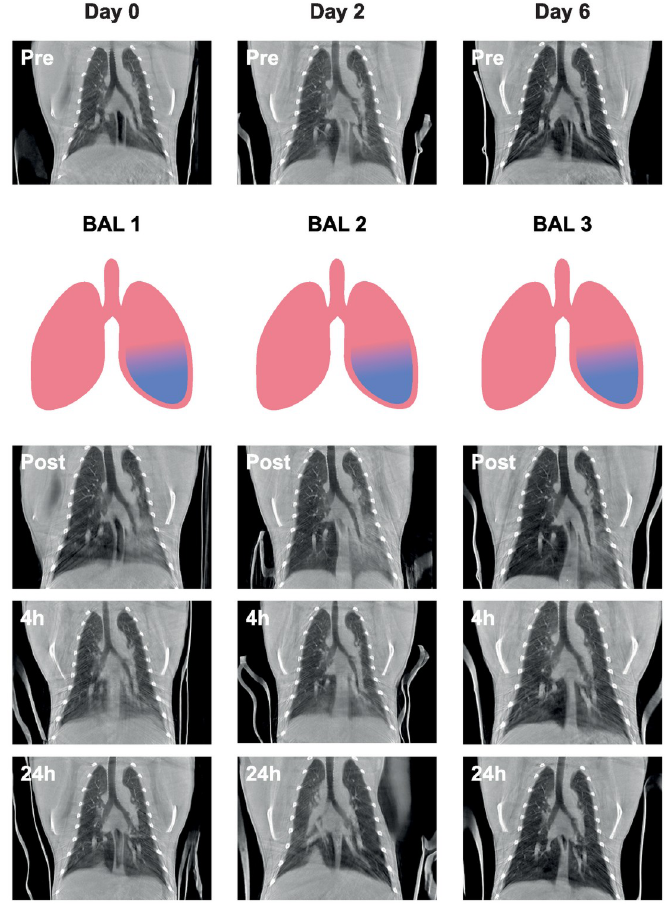
Fig 1. Representative coronal slices (of RM2) of all CTs obtained during the three BALs. The procedures are represented in a vertical manner whereas the time in days is represented horizontally. The procedure starts with a pre- BAL CT (Pre), followed by a left-sided (blue) BAL 1, a post-BAL CT (Post) and a four hour post-BAL CT (4h) on Day 0. The next day, Day 1, the 24 hour post-BAL CT (24h) was obtained. The procedures for BAL 2 and BAL 3 were performed in a similar